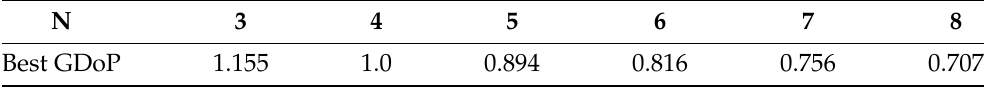
Table 1. Best achievable GDoP vs. number of antennas.